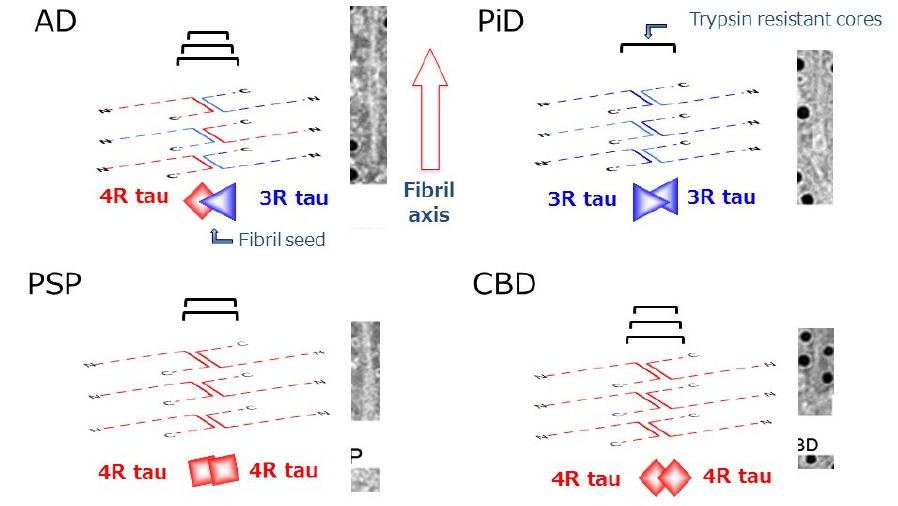
Figure 4. Schematic diagrams of amyloid-like tau fibril formation in tauopathies. In AD, a heterodimer composed of 3R and 4R tau isoforms can seed fibril formation, while only homodimer composed of 3R tau or 4R tau isoforms alone can seed fibril formation in PiD and CBD (or PSP), respectively. The trypsin-resistant tau may represent the core regions of the tau fibrils, which are characteristic for each